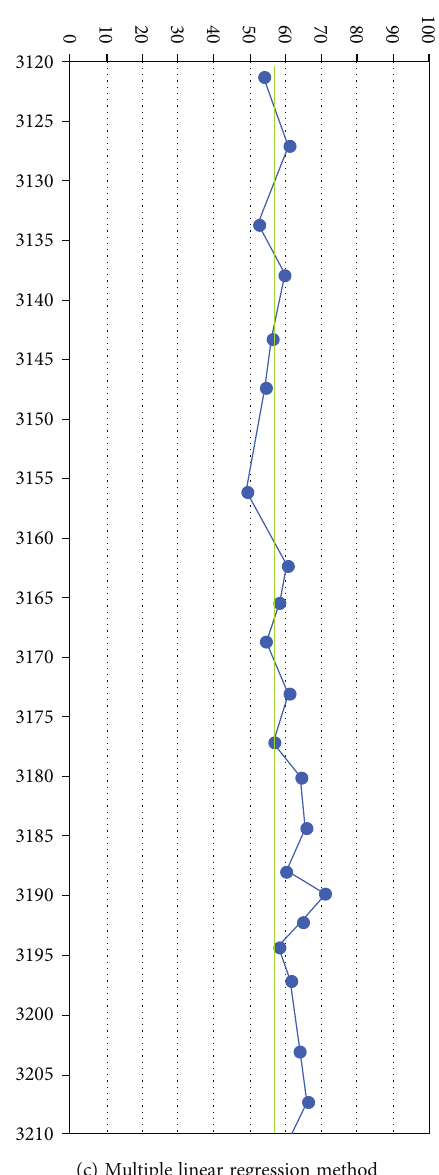
Figure 9: Calculation results of rock brittleness of di ff erent